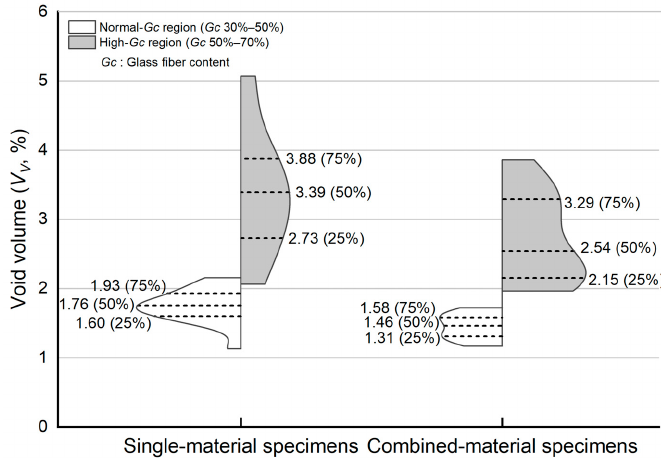
Figure 9. Variations of the ( a ) void volume with G c , and ( b ) relative density with G c with consideration of the void volume.